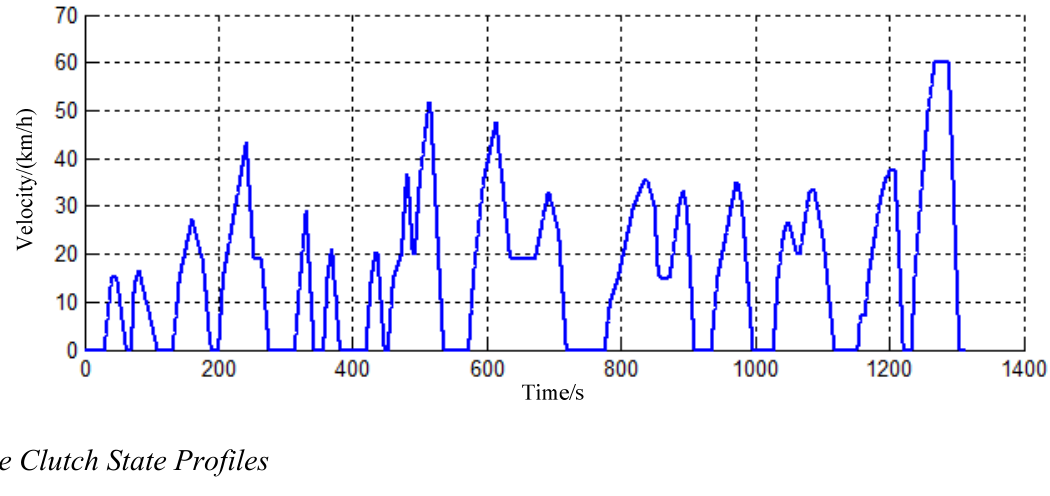
Figure 10. The velocity profile of the CSUDC